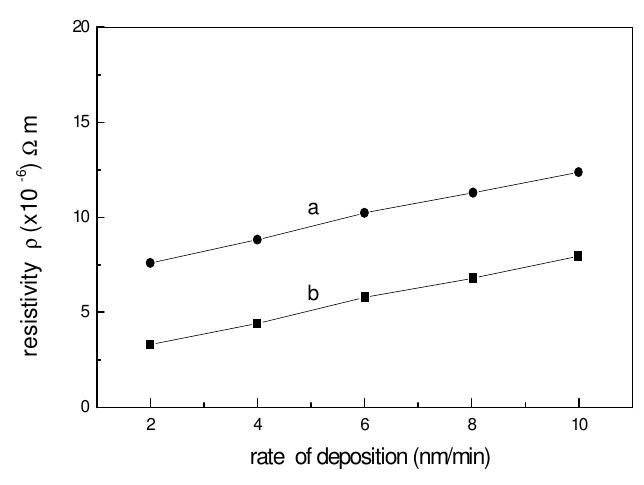
Figure 1 . Resistivity as a function of substrate temperature .